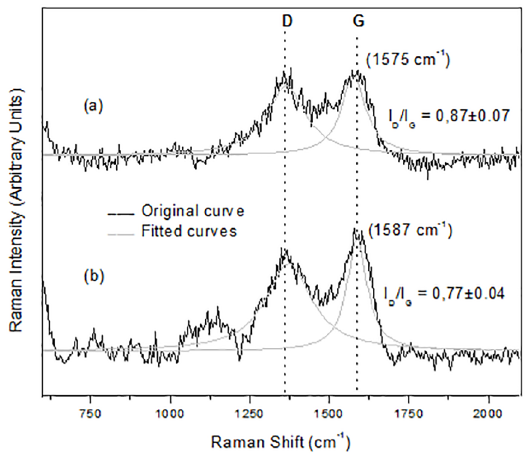
Figure 6. Raman spectra of Ni-2: (a) before the heat treatment and (b) after heating treatment at fast heating rate